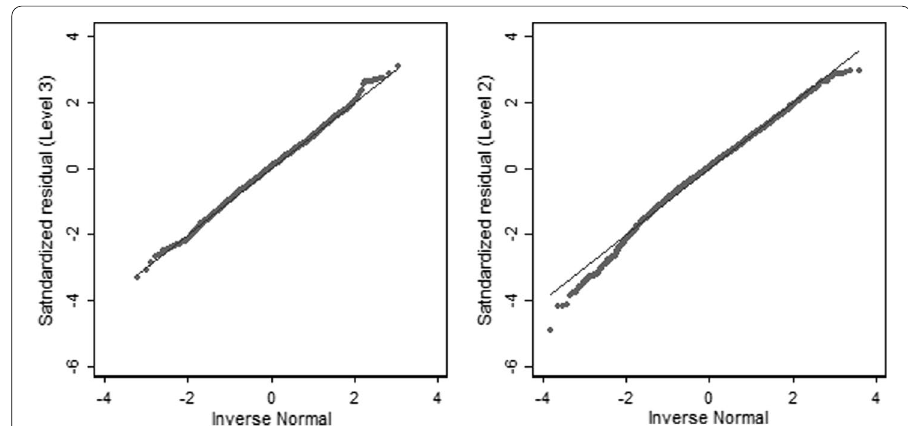
Fig. 2 QQ plots of standardized residuals at Level3 and Level2